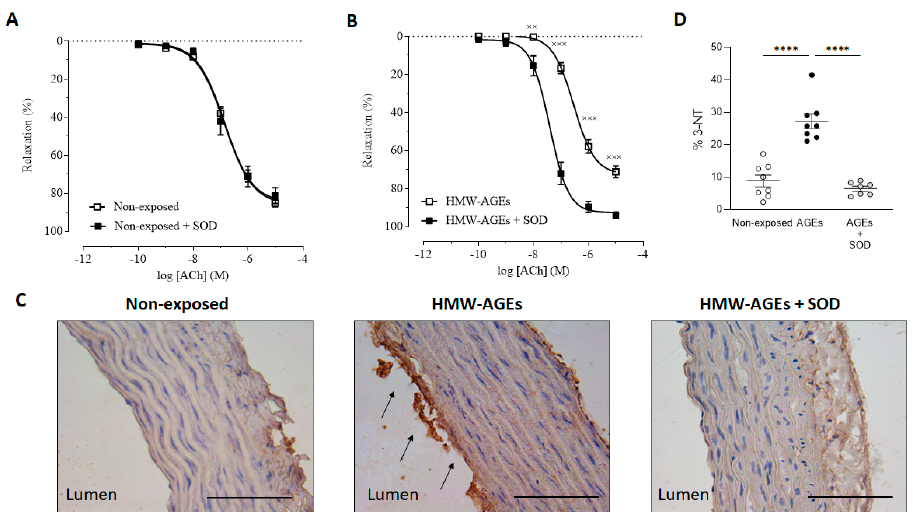
Figure 2. SOD improves endothelium-dependent vasorelaxation, by limiting oxidative stress, in aortic rings after acute HMW-AGEs exposure. Aortic rings were pre-treated with superoxide dismutase (SOD, 150 kU) for 30 min. The relaxation response is expressed as the percentage relaxation relative to phenylephrine-induced (final bath concentration: 10 − 7 M) precontraction. Relaxation response to cumulative doses of acetylcholine (ACh, final bath concentrations: 10 − 10 –10 − 5 M) in aortic rings ( A ) Left non-exposed ( n = 48, N = 15) and preincubated with SOD alone for 30 min ( n = 12, N = 3), ( B ) Preincubated with HMW-AGEs ( n = 24, N = 13) and both HMW-AGEs and SOD ( n = 12, N = 7). Data points are visualised as mean ± SEM. ×× p < 0.01 and ××× p < 0.001. ( C ) Representative images of 3-nitrotyrosine (3-NT) staining in transverse aortic tissue sections from non-exposed, HMW-AGEs exposed, and both HMW-AGEs and SOD exposed aortic rings. In aortic rings preincubated with HMW-AGEs, clear staining of the endothelium (intima) was observed (arrows). Scale bars represent 100 µm. ( D ) Quantification of 3-NT from non-exposed ( N = 8), HMW-AGEs exposed ( N = 8), and both HMW-AGEs and SOD exposed ( N = 7) aortic tissue sections. The sample size is indicated as ‘n’ (number of aortic rings) or ‘N’ (number of rats). Data are presented as mean ± SEM. **** p < 0.001.